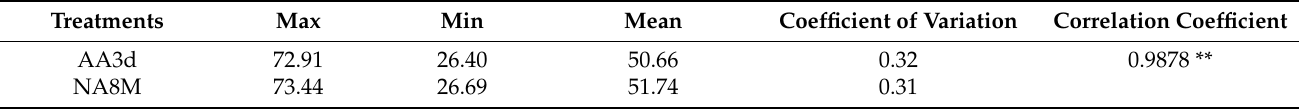
Table 2. Correlation analysis for MDA content between AA3d and NA8M